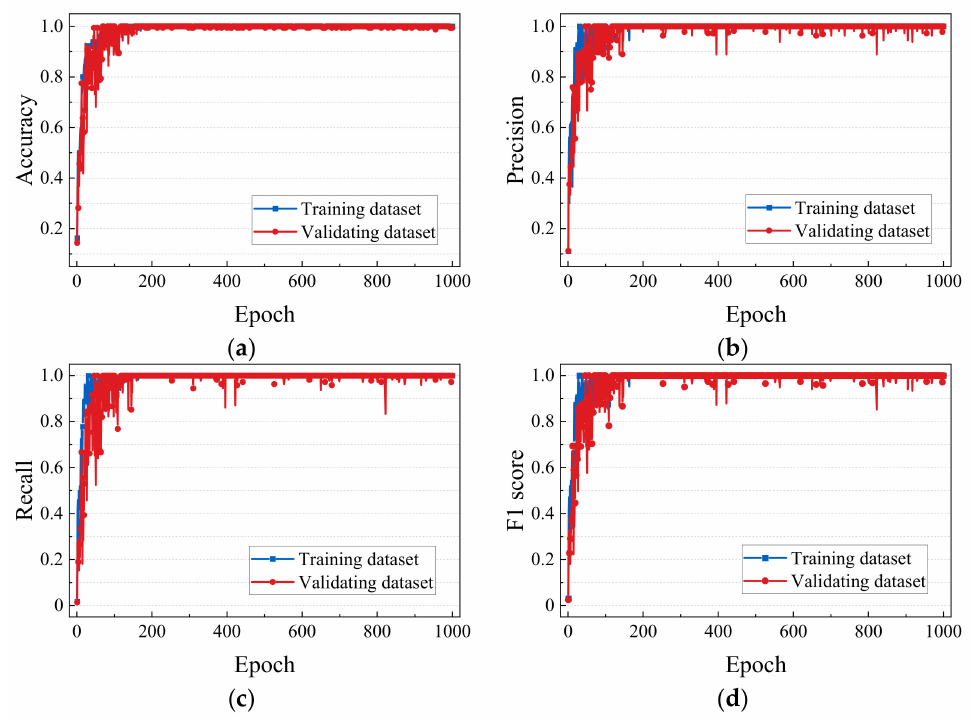
Figure 26. The process of training: ( a ) the results of accuracy; ( b ) the results of precision; ( c ) the results of recall; ( d ) the results of F1 score.